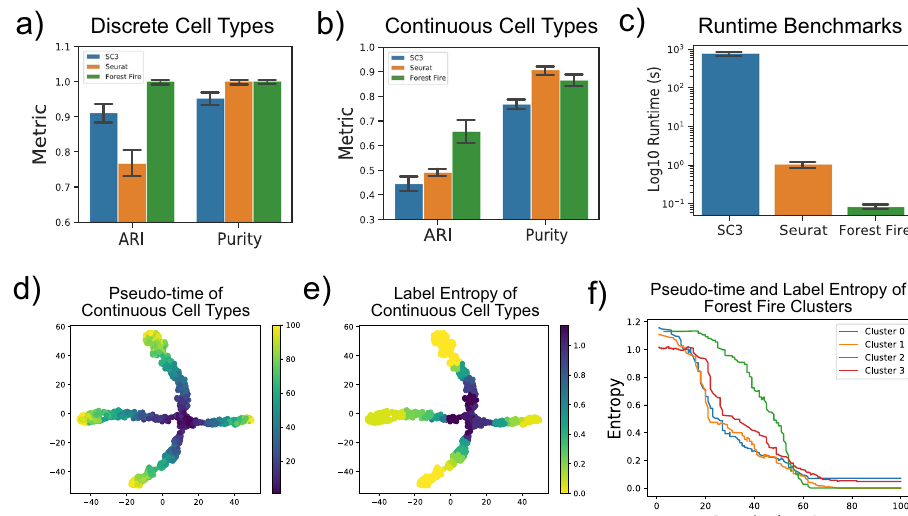
Fig. 4 Simulated scRNA-seq analysis. a Discrete cell types were simulated with Splatter ( n = 20 independent datasets) and used to benchmark SC3, Seurat (Louvain), and Forest Fire Clustering. With fi ve discrete cell types, Forest Fire Clustering outperforms SC3 and Seurat in ARI and SC3 in purity score. b Continuous cell types were simulated with Splatter ( n = 20 independent datasets) and used to benchmark SC3, Seurat (Louvain), and Forest Fire Clustering. With four cell developmental paths, Forest Fire Clustering outperforms SC3 and Seurat in ARI and SC3 in purity score. c Forest Fire Clustering outperforms SC3 and Seurat in runtime ( n = 20 independent datasets). Data are presented as mean values + / − 2SD. d , e For continuous cell paths, a stem cell type differentiates into four cell types. As the pseudo-time step increases, each cell type becomes more specialized. Forest Fire entropy is able to mimic the pseudo-time step along the data manifold. f Within each cluster, label entropy negatively correlates with pseudotime.